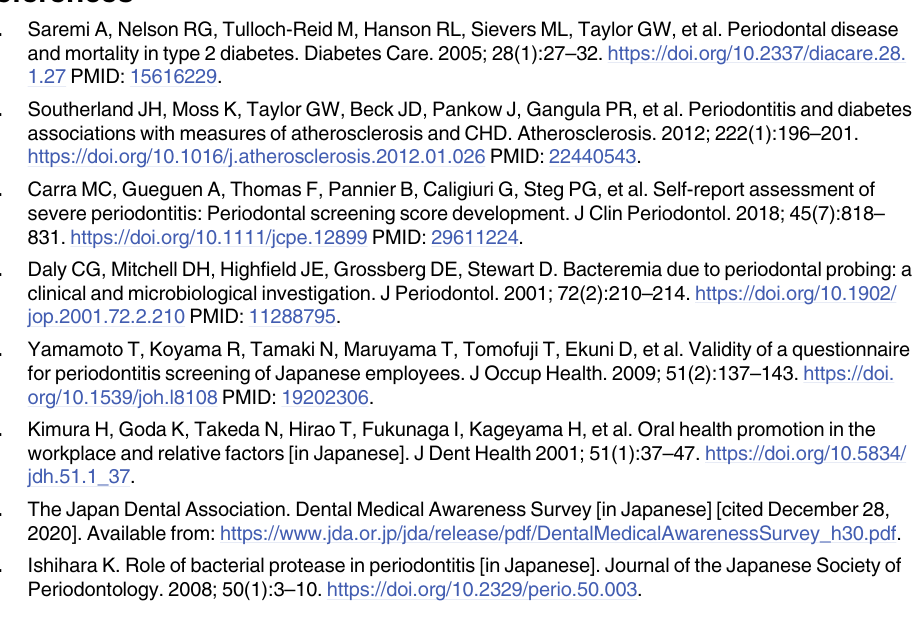
S1 Table. Logistic regression models for periodontitis based on the AAP/EFP definition among Japanese workers ( n =